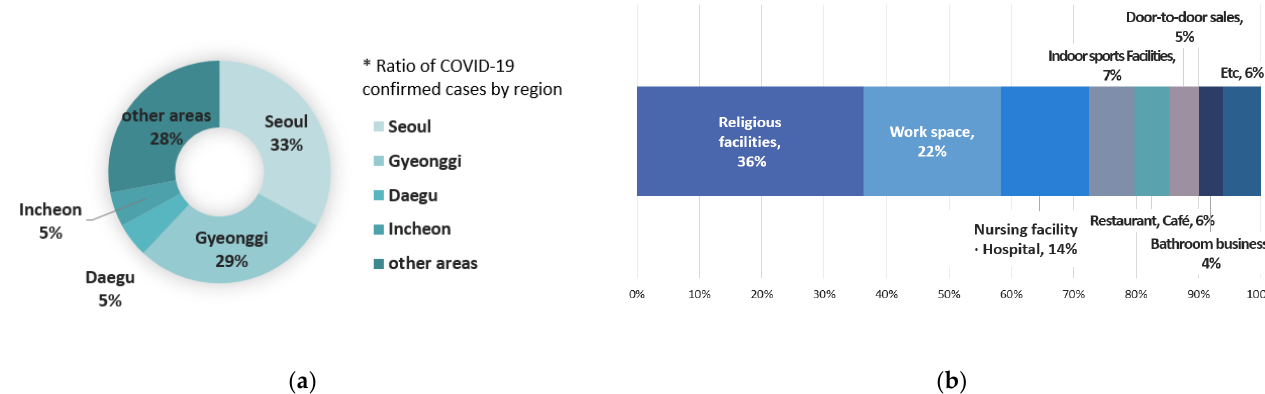
Figure 1. ( a ) Ratio of confirmed cases of COVID-19 by region in Korea [5]; * ratio of COVID-19 confirmed cases by region; ( b ) cases of mass infection of COVID-19 in multi-use facilities in Seoul [11]. All values are as of November 2021.